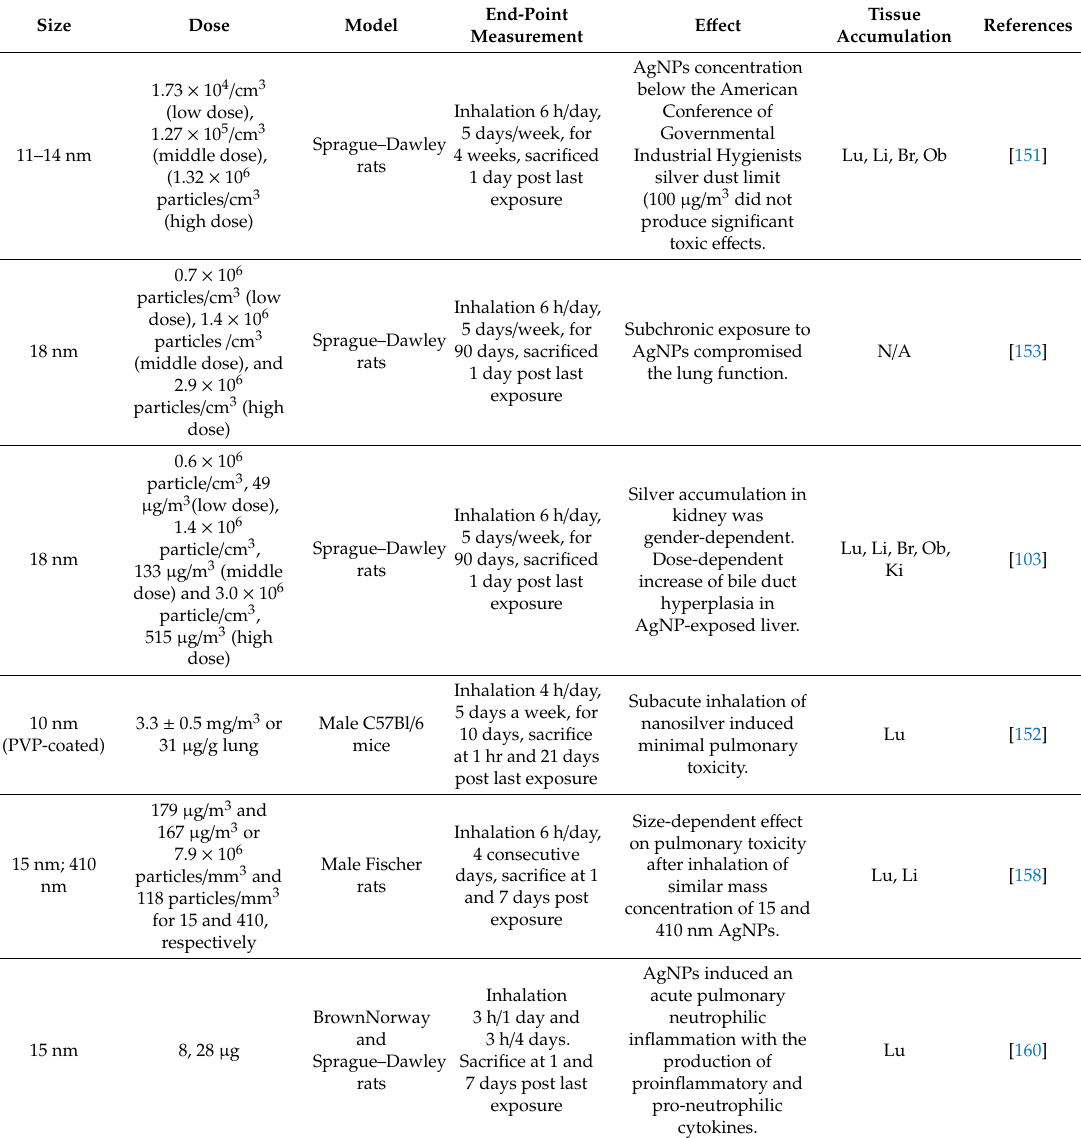
Table 1. Toxicity and distribution of AgNPs following pulmonary exposure in rodents via